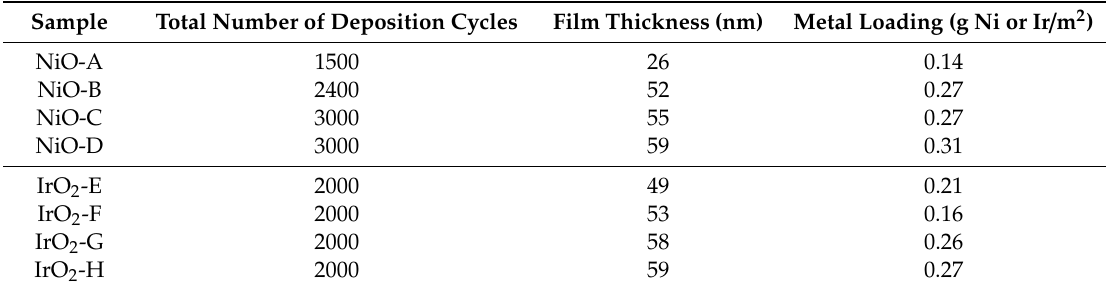
Table 1. Film thickness and metal loading of the electrode